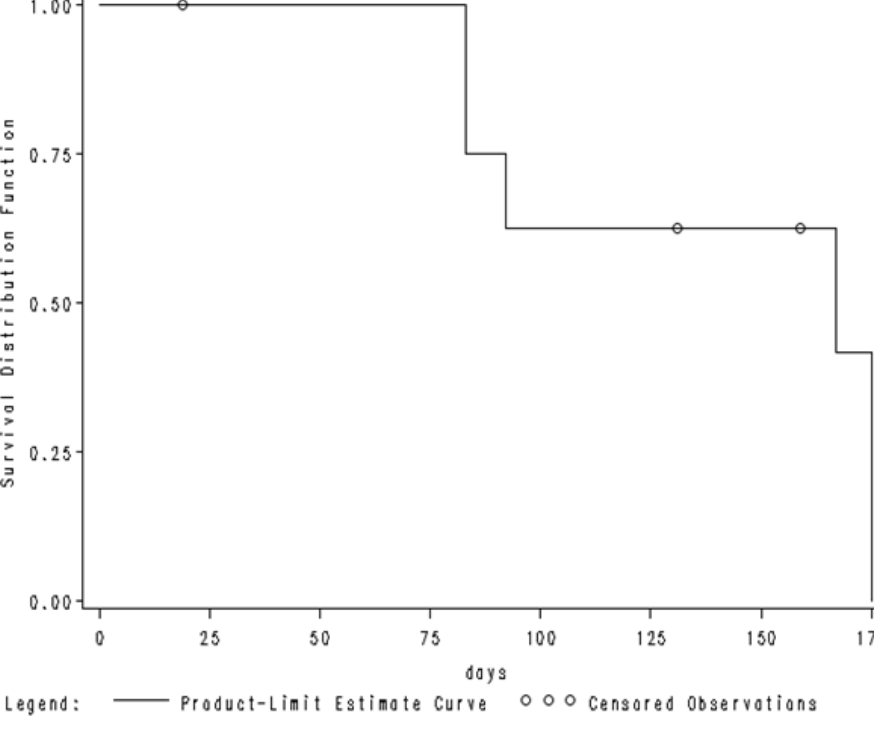
Fig. 3. Progression-free survival of patients with colorectal